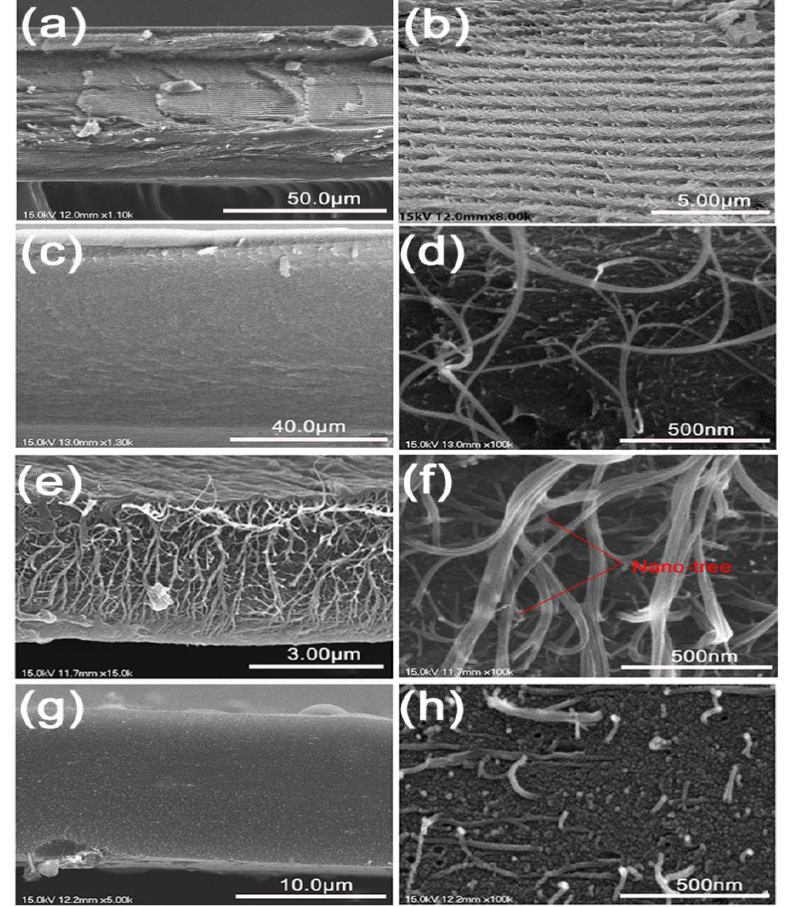
Figure 5. Cross-section morphologies of ( a , b ) CNC 70 , ( c , d ) CNT–CNC 70 , ( e , f ) CNT–CNC 800 , and ( g , h ) CNT–CNC 1300